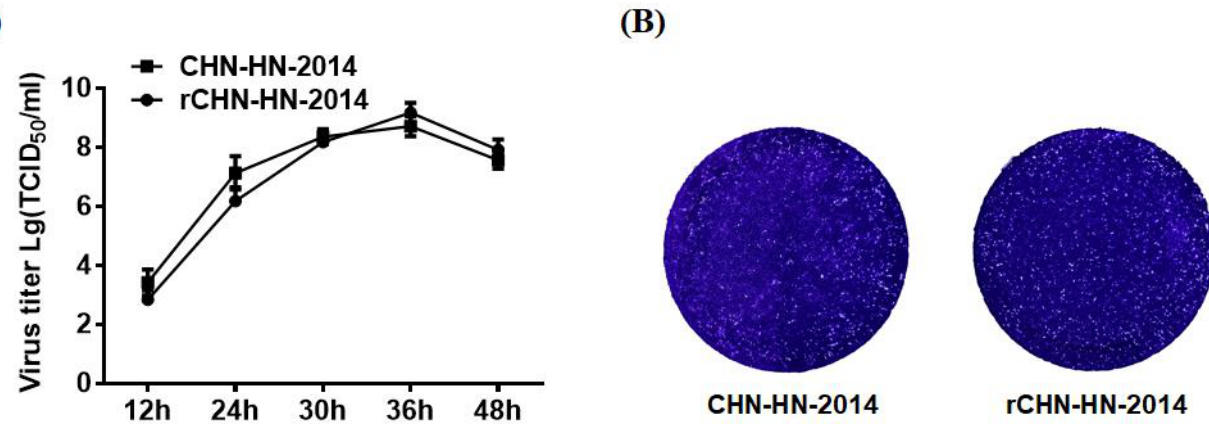
Figure 3. In vitro growth characterization of the CHN-HN-2014 and rCHN-HN-2014. ( A ) Multiple-step growth curves of the CHN-HN-2014 and rCHN-HN-2014 on LLC-PK cells. Cells were infected with CHN-HN-2014 and rCHN-HN-2014 at an MOI of 0.01, and cell supernatants were collected at the various time points post-infection, followed by TCID 50 assays on LLC-PK cells. ( B ) Plaque morphology and size of the rCHN-HN-2014 in LLC-PK cells are similar to that of the CHN-HN-2014. (Magnification: 10×).